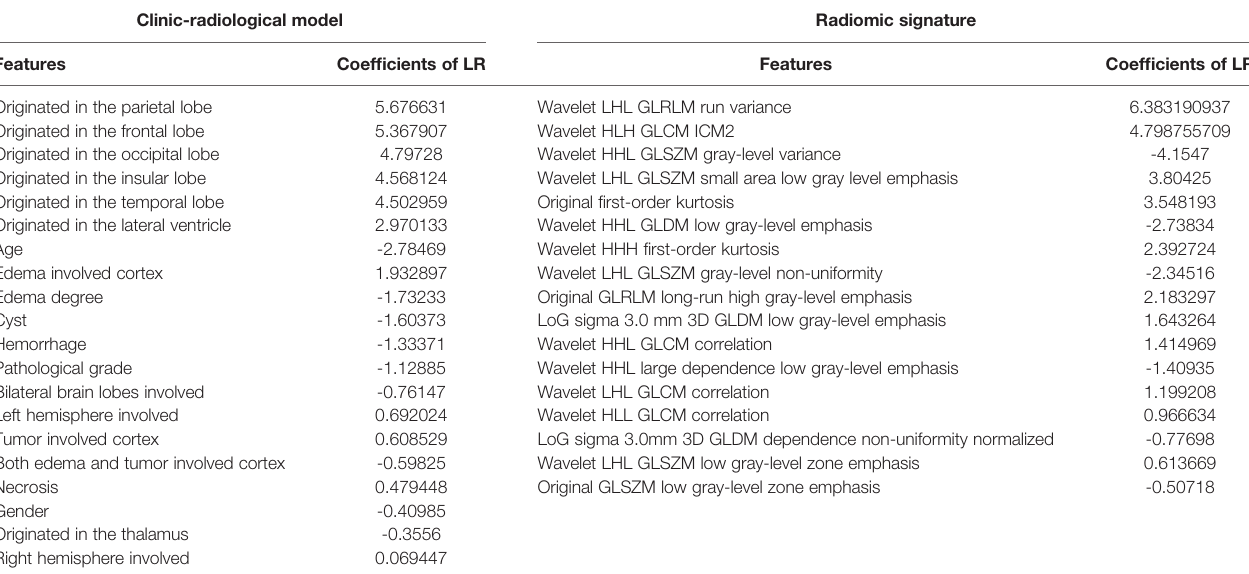
TABLE 2 | Selected features and the coef fi cients of features in the clinic-radiological and radiomic signature for predicting glioma-associated epilepsy. Clinic-radiological